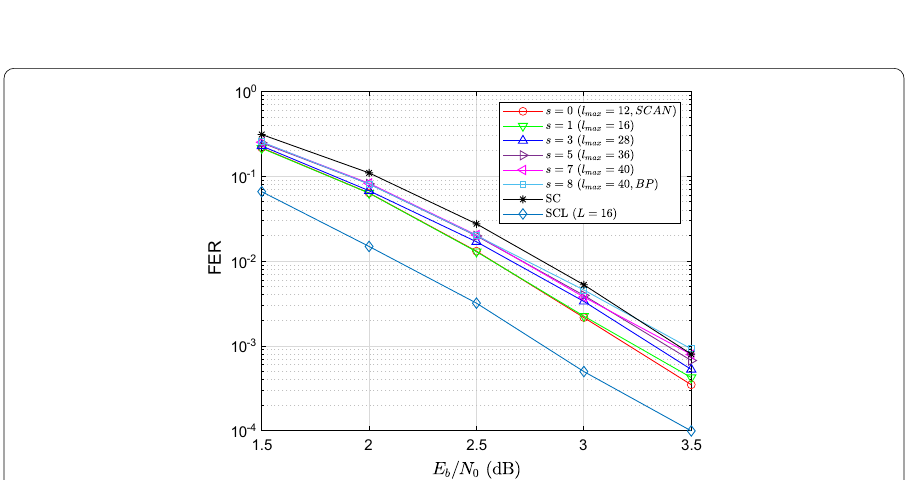
512 and R 1 / 2 . The = =